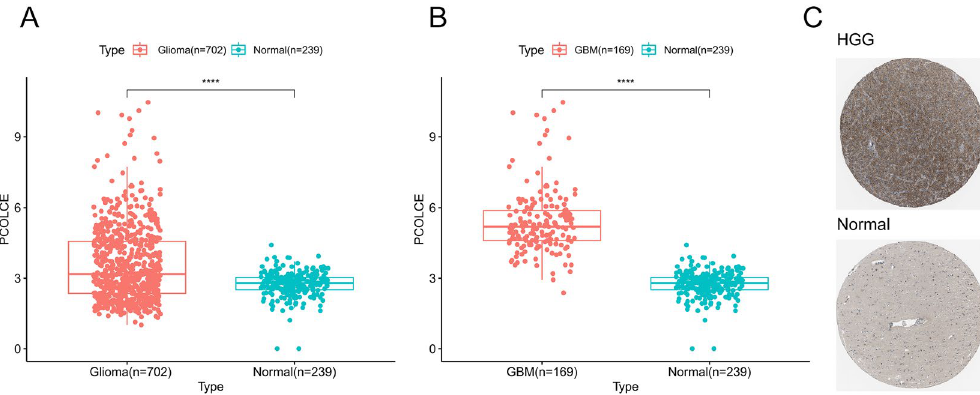
Figure 1. The expression level of PCOLCE in glioma. ( A ) Expression of PCOLCE in glioma based on the TCGA database and normal tissues based on the GTEx database. ( B ) Expression of PCOLCE in GBM based on the TCGA database and normal tissues based on the GTEx database. ( C ) PCOLCE levels in high-grade glioma and normal tissues is based on the Human Protein Atlas. ****P <